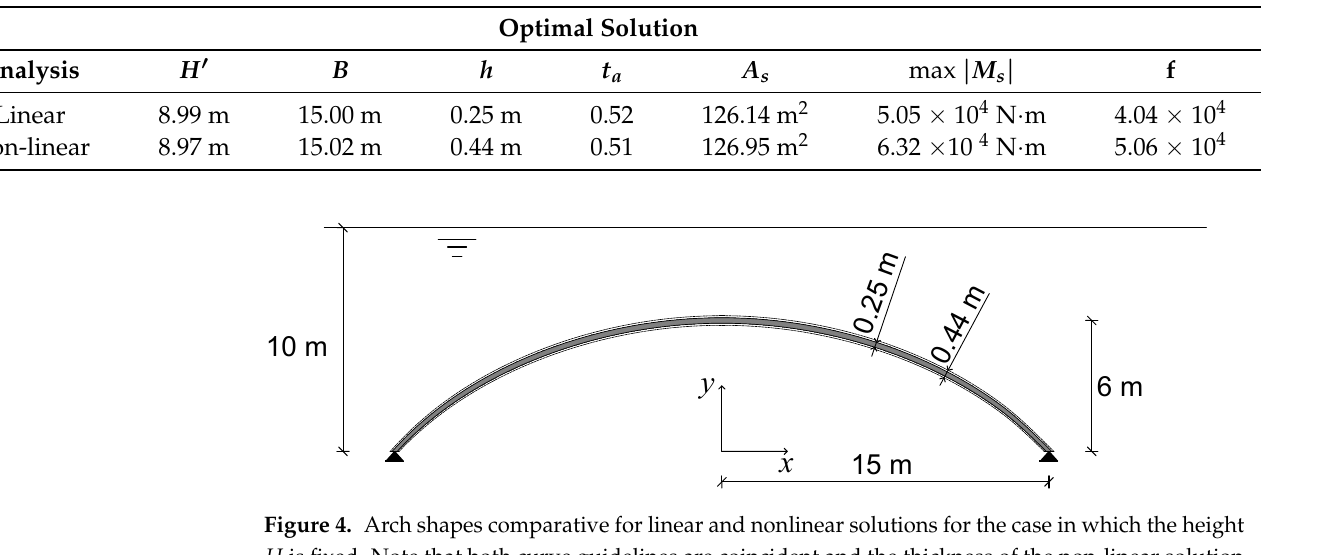
Table 3. Arch shapes comparative for optimal solutions found by the CRO-SL in the linear and the nonlinear cases in which the height H is fixed.